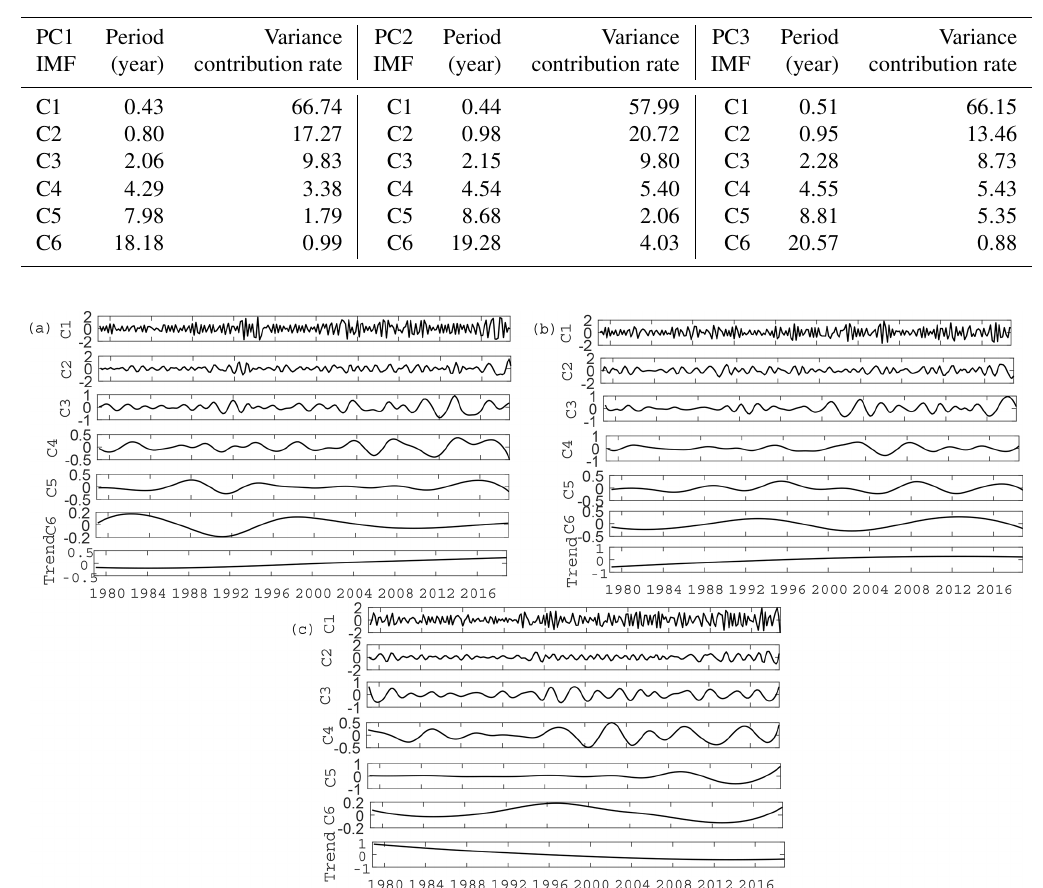
Table 1. The period and variance contribution rate of each IMF mode